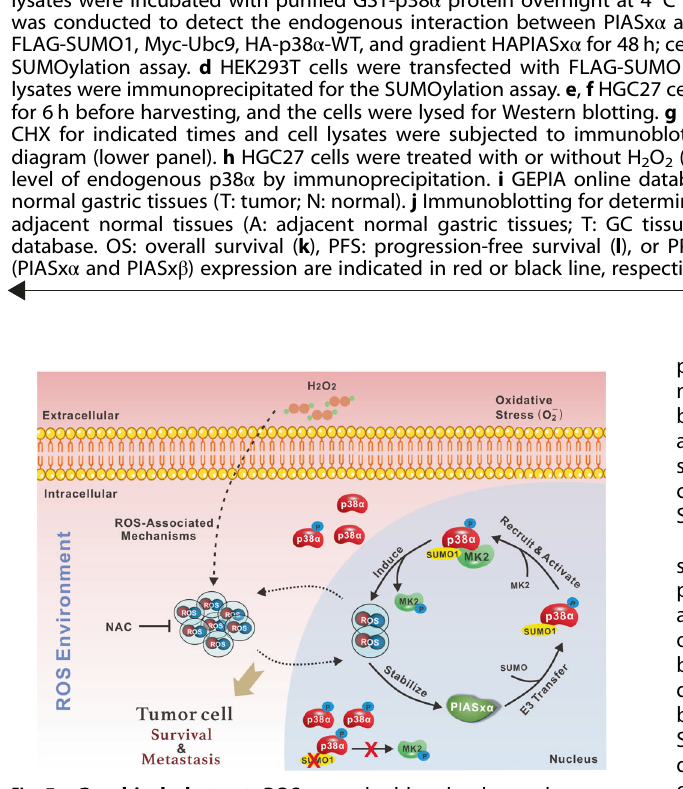
Fig. 7 Graphical abstract. ROS, as a double-edged sword, possess both pro- and anti-tumorigenesis properties, which depends primarily on intracellular ROS level and tumor type. In gastric cancer, the oxidative stress sensor p38 α can undergo SUMO1 modi fi cation to facilitate its nuclear translocation, and p38 α - SUMOylation is essential for the activation of MK2 in the nucleus, thereby mediating ROS generation in cells. Meanwhile, an appro- priate amount of ROS can stabilize SUMO E3 ligase PIASx α and further promote the SUMOylation of p38 α , thus forming a positive feedback between ROS and cis -axis PIASx α /p38 α -SUMOylation/MK2. This speci fi c regulatory mechanism is exploited by gastric cancer cells to maintain initial tumor cell survival and further metastasis.